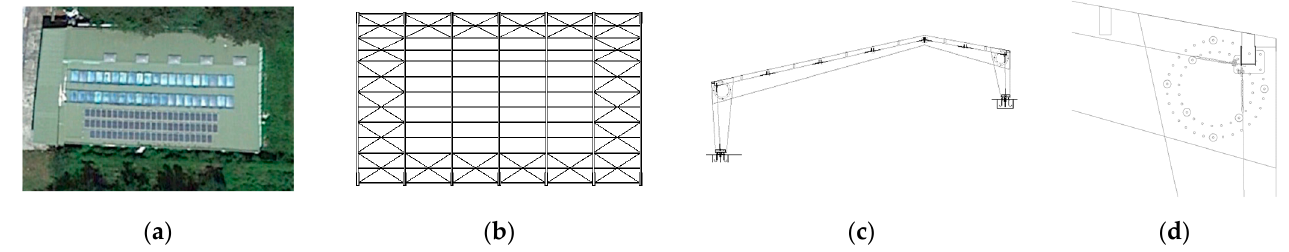
Figure 5. Pool in Acquasanta Terme (AP, 2006): ( a ) external view, ( b ) plan view, ( c ) section along main beams, and ( d ) detail of the connection between column and main beam (courtesy of Rubner Holzbau).